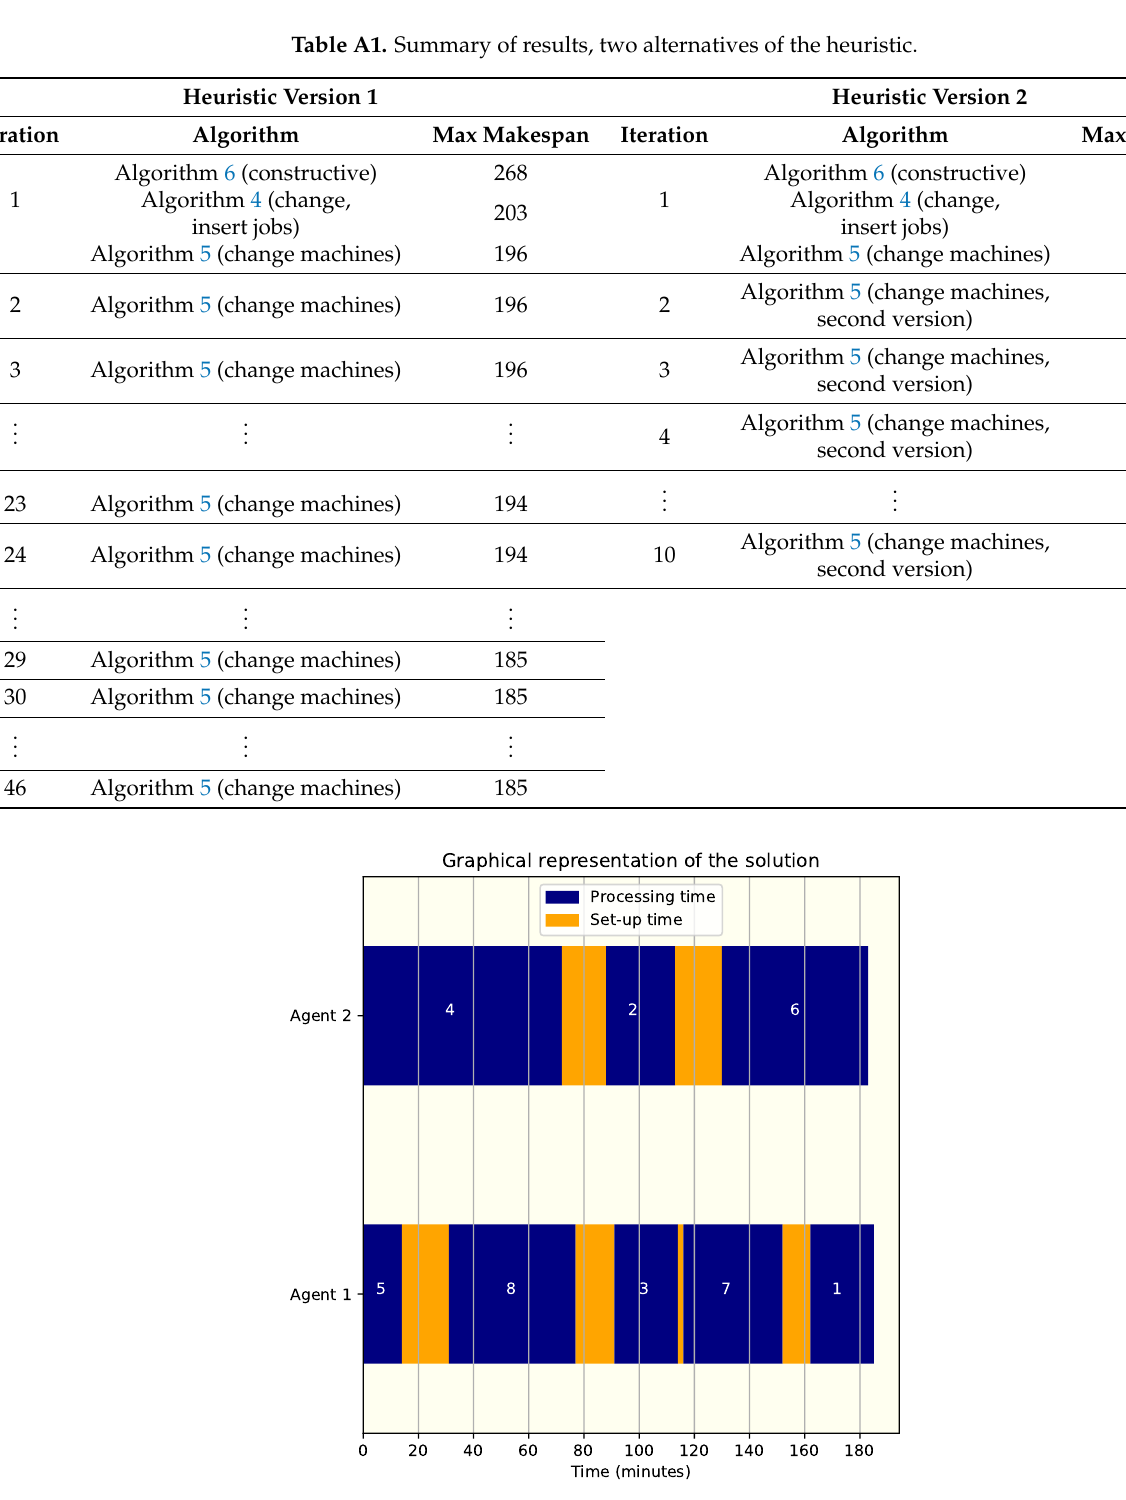
Figure A1. Graphical solution of the instance used for the exemplification of the